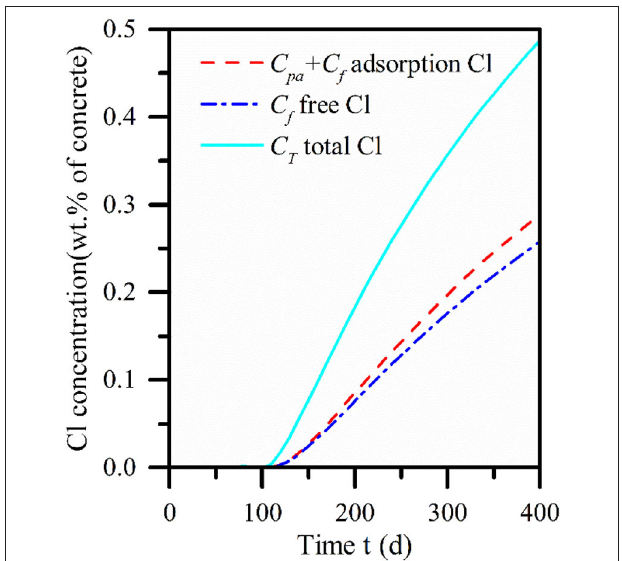
FIGURE 10 | Concentration of chemically bound chloride ions at different sulfate ion concentrations.